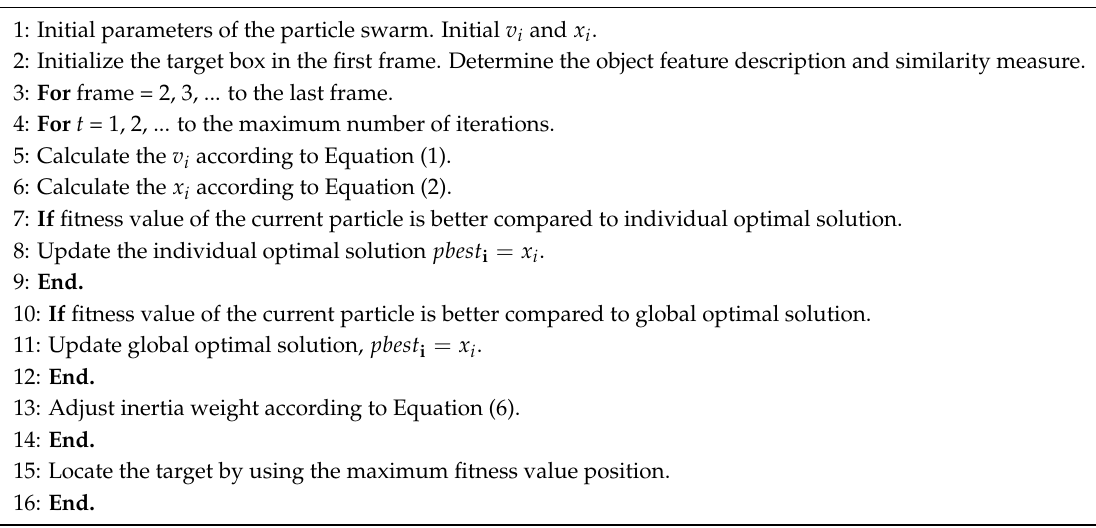
Algorithm 1. Improved particle swarm optimization object tracking